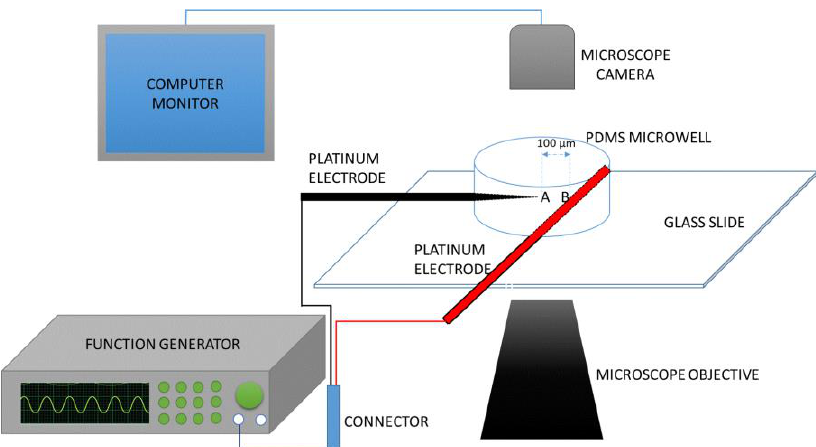
Figure 1. The experimental set-up for the measurement of dielectrophoresis (DEP) crossover frequency using a novel microwell platform to obtain electrophysiological properties, i.e., conductivity and permittivity of peripheral blood mononuclear cell (PBMCs) and adenocarcinoma cells (ADCs) that will aid in designing an early detection platform for breast